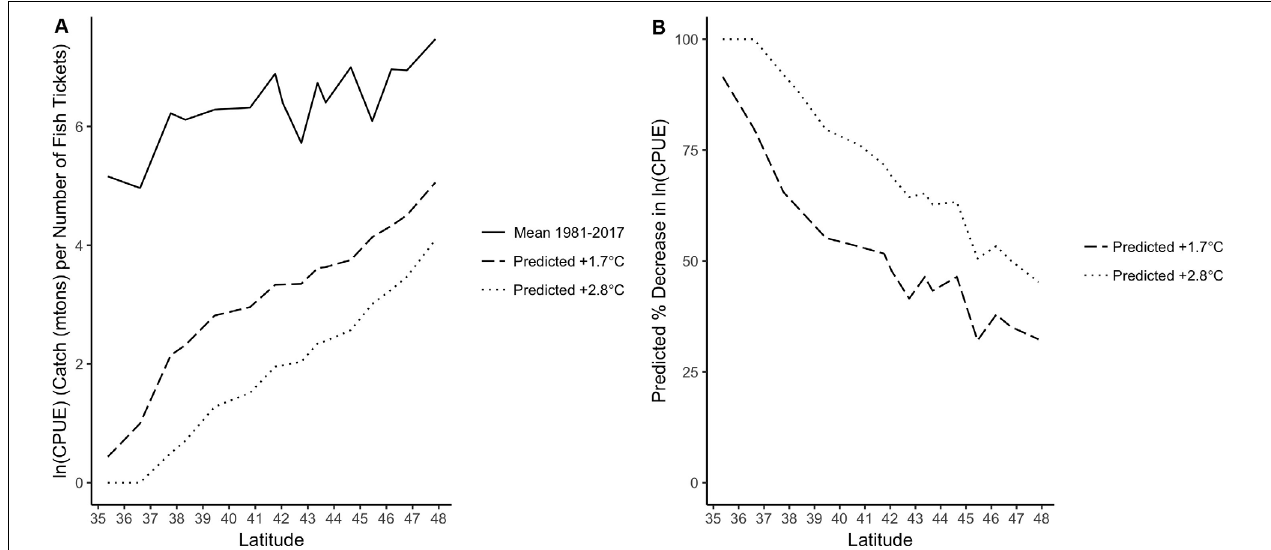
FIGURE 6 | (A) Mean Dungeness crab ln(CPUE) along the U.S. west coast from 1981 to 2017 (solid line) and VC_GAMM predicted CPUE along the U.S. west coast under two future SST scenarios: +1.7 ◦ C (dashed) and +2.8 ◦ C (dotted). (B) VC_GAMM predicted percent decrease in Dungeness crab ln(CPUE) by latitude along the U.S. west coast based on two future SST scenarios: +1.7 ◦ C (dashed) and +2.8 ◦ C (dotted).